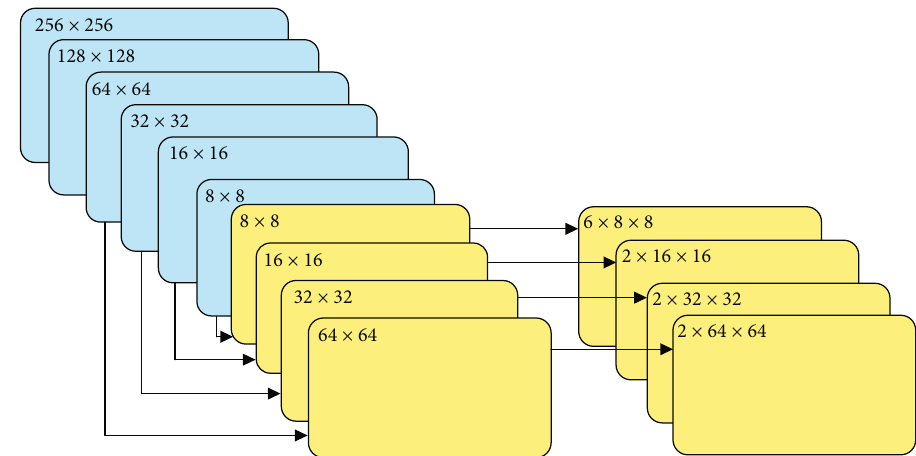
Figure 6: Structure of palm detector [9]. The blue squares are the encoders, and the yellow squares are the decoders.